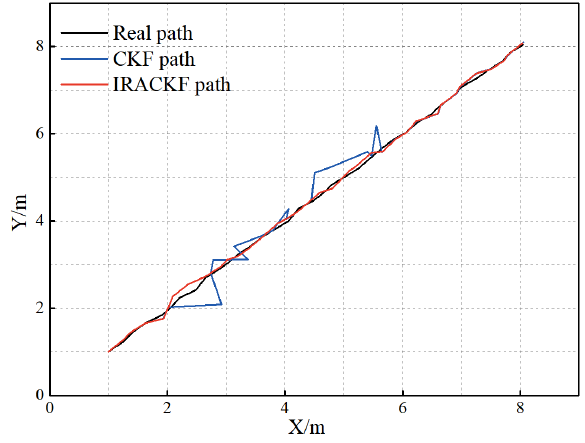
Figure 13. The tag movement trajectory for each filtering solution.